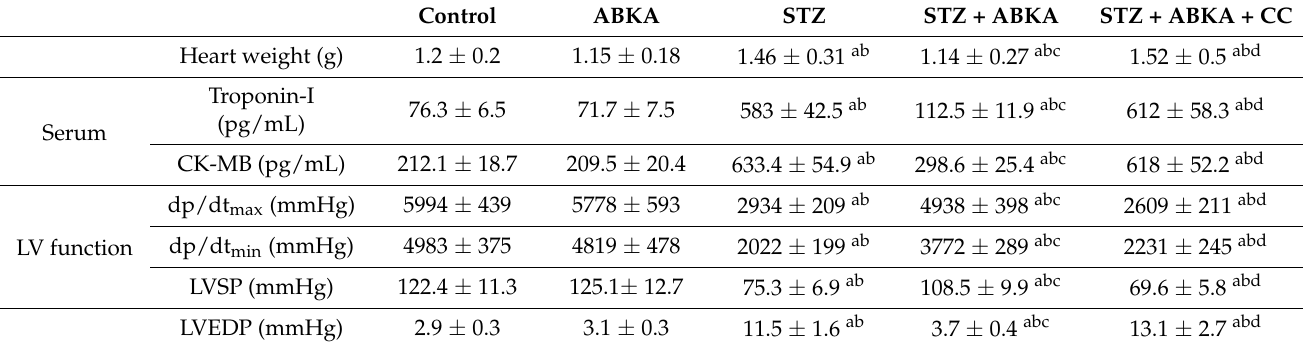
Table 2. Levels of cardiac enzymes and markers of left ventricular (LV) function in the rats of all groups. Control ABKA